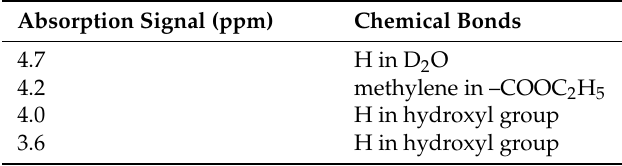
Table 3. 1 H NMR spectra assignment of polysaccharide chemical bonds.